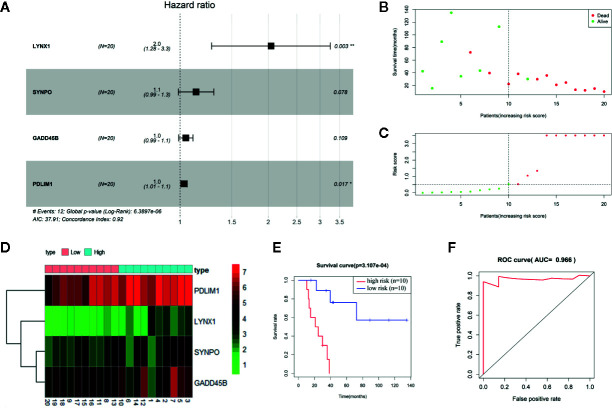
Construction of persister-gene based prognostic signature in NSCLC. (A) A radiotherapy prognostic signature containing four persister genes was developed using stepwise regression analysis. Risk ratio (HR), 95% confidence interval, and coefficient in forest map were calculated by multivariate Cox regression analysis. (B) Distribution of survival time in enrolled NSCLC patients who received radiotherapy (n = 20). (C) Patients were separated into high- and low-risk groups based on the median of risk scores. (D) Gene expression matrix of four key persister genes in high- and low-risk groups. Green, red, and black respectively define a lower expression level, a higher expression level, and no expression difference. (E, F) Survival curve and ROC curve validation of the prognostic efficiency of the risk score. AUC, area under curve; HR, hazard ratio; ROC, receiver operating characteristic.